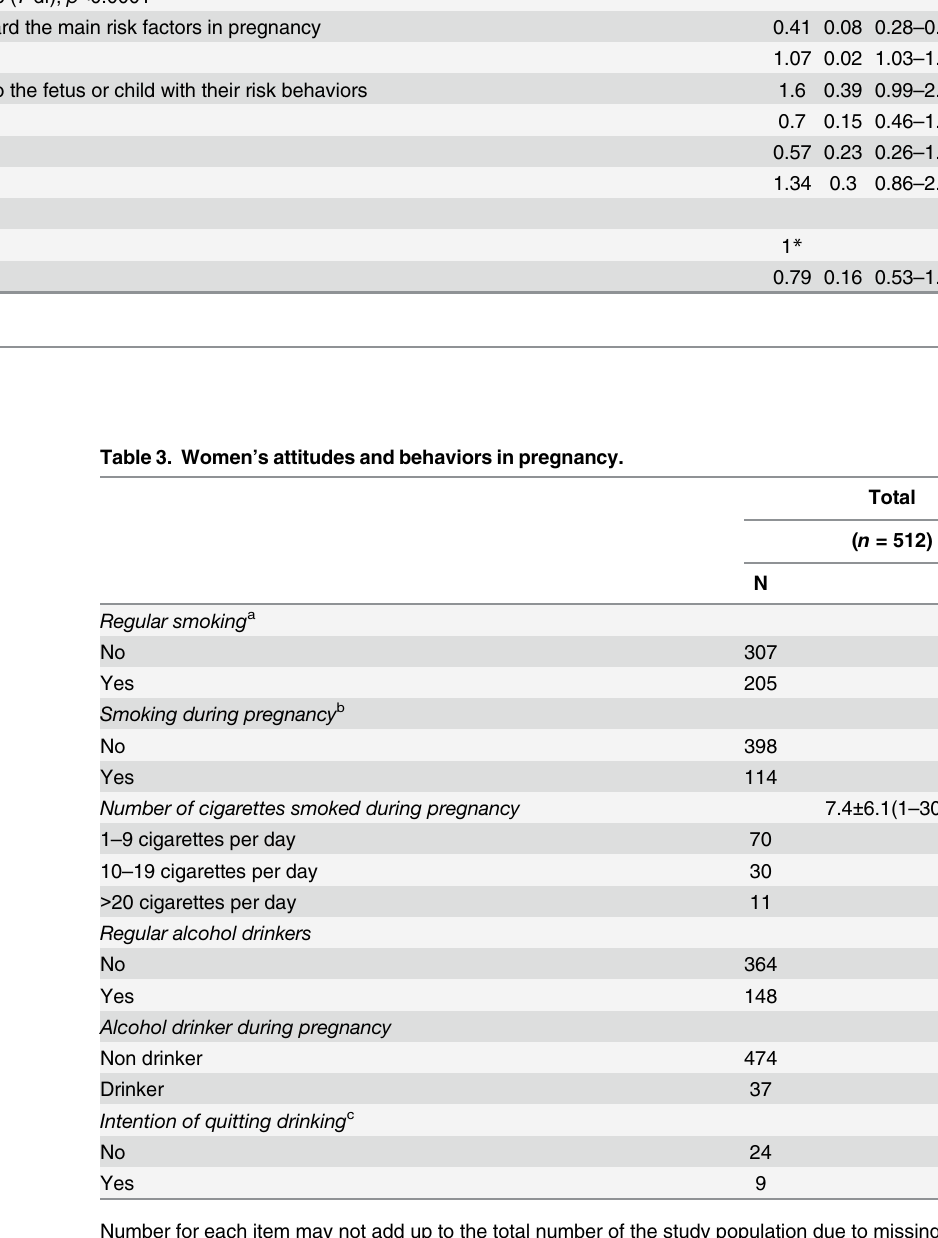
Model 4 . Pro fi le of women who have received information by physicians during ambulatory gynecological examinations about main risk factors in pregnancy